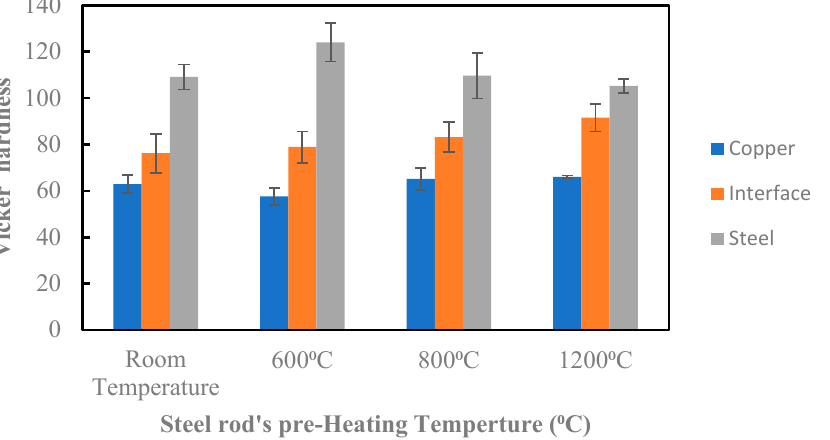
Figure 9. Vickers hardness of copper, interface, and steel rod at various preheated temperatures of steel rod.